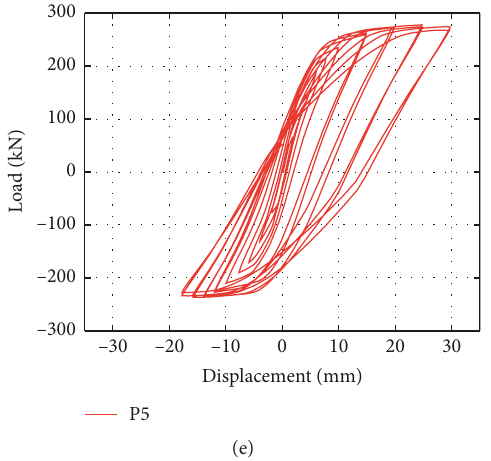
Figure 15: Hysteresis curves of numerical models.